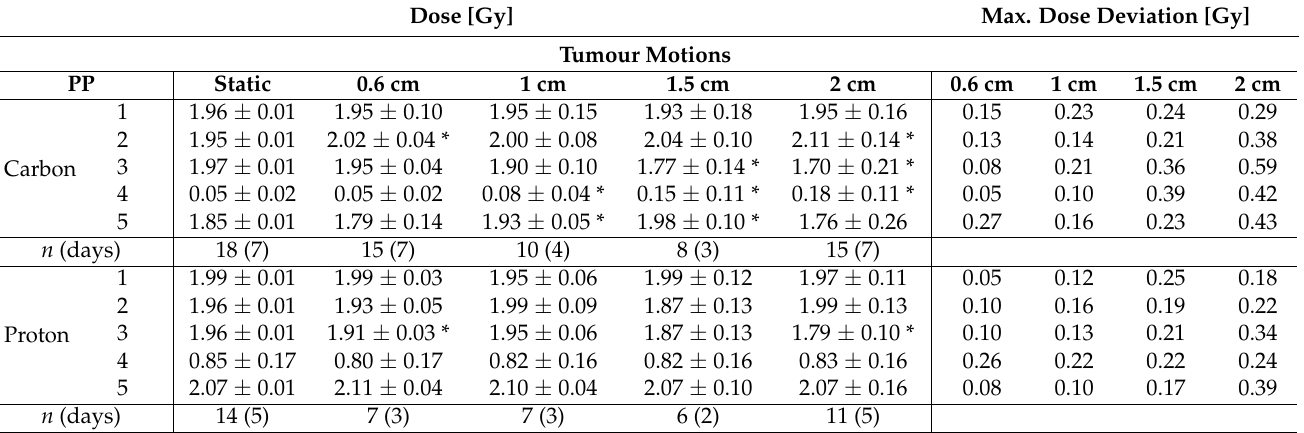
Table 2. Average dose values and their related standard deviation (SD) for the different PP locations for the carbon and proton measurements; additionally, the absolute maximal dose deviation is given, the asterisk (*) means statistically significant compared to the static measurement ( p < 0.05), n is the total number of measurements, and ‘days’ is the number of measurement days. Dose [Gy] Max. Dose Deviation [Gy] Tumour